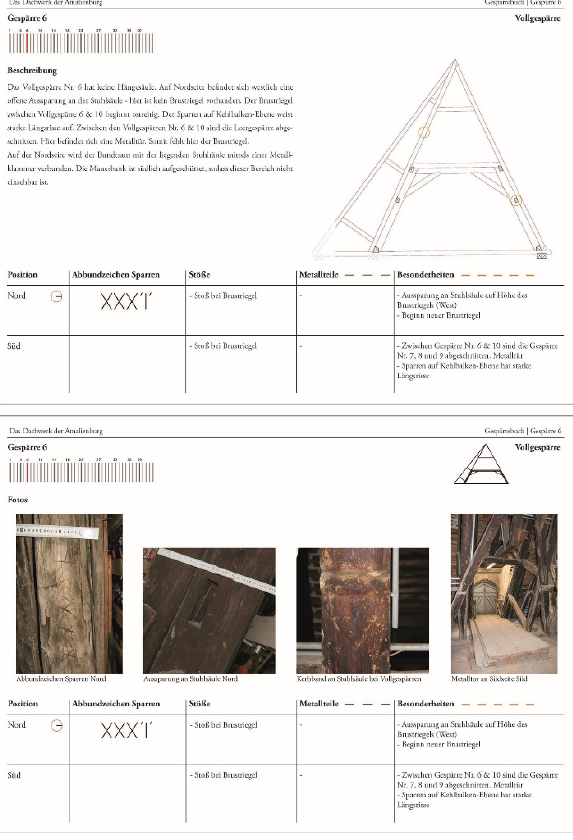
Figure 1: Section of the catalogue of rafters of the north-east wing of the Amalienburg (© A. Domej, N. Hamader, B. Kapsammer, all TU Wien,